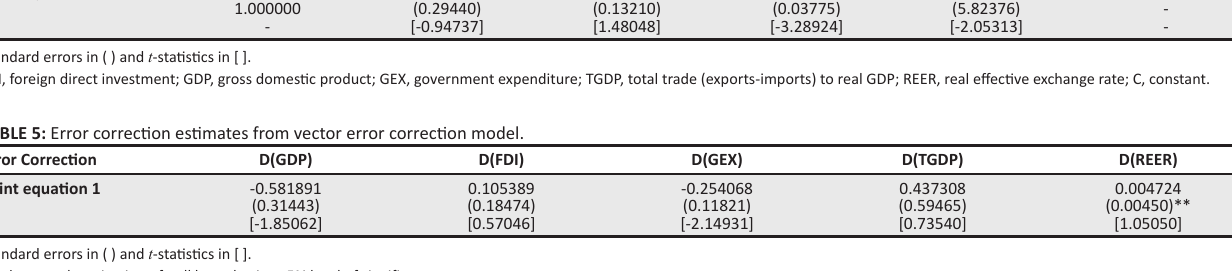
TABLE 4: Long-run normalised cointegrating equation. Cointegrating equation Coint equation